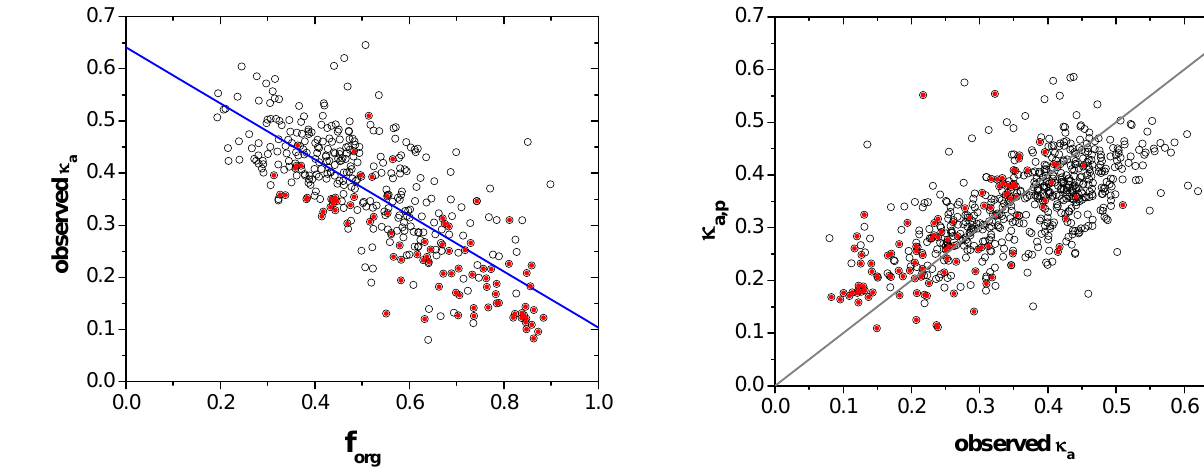
Fig. 3. Correlation between the observed effective hygroscopic- ity parameter of CCN-active particles ( κ a ) and the organic mass fraction ( f org ) determined by size-resolved AMS measurements for the entire campaign. Data points at which m D < 1µgm − 3 are excluded. Red dots indicate the data points measured during the BBE. The blue line is a linear least squares fit with the follow- ing equation, correlation coefficient, and number of data points: y = 0 . 64 − 0 . 54 · x , R 2 = 0 . 57, n = 379.